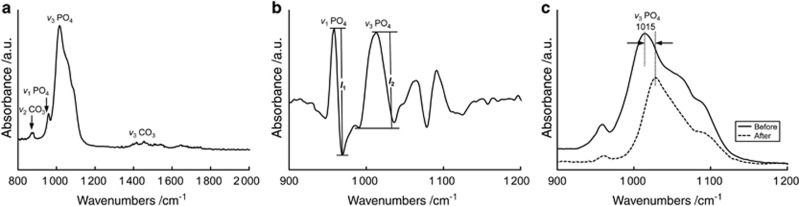
Methods for quantifying the degree of erosion using ATR-FTIR spectroscopy. (a) Baseline-corrected IR spectra in the region of 800–2 000 cm−1. (b) The peak-to-peak measurement technique applied to spectra that were initially second-derivative transformed and then multiplied by −1. The ratio of the height of ν3 PO4 (l2) to that of ν1 PO4 (l1) was calculated (Method 1). (c) A shift of the ν3 PO4 peak (~1 015 cm−1) to a higher wavenumber after erosion treatment was investigated (Method 2). ATR-FITR, attenuated total reflection Fourier transform infrared; a.u., arbitrary unit.